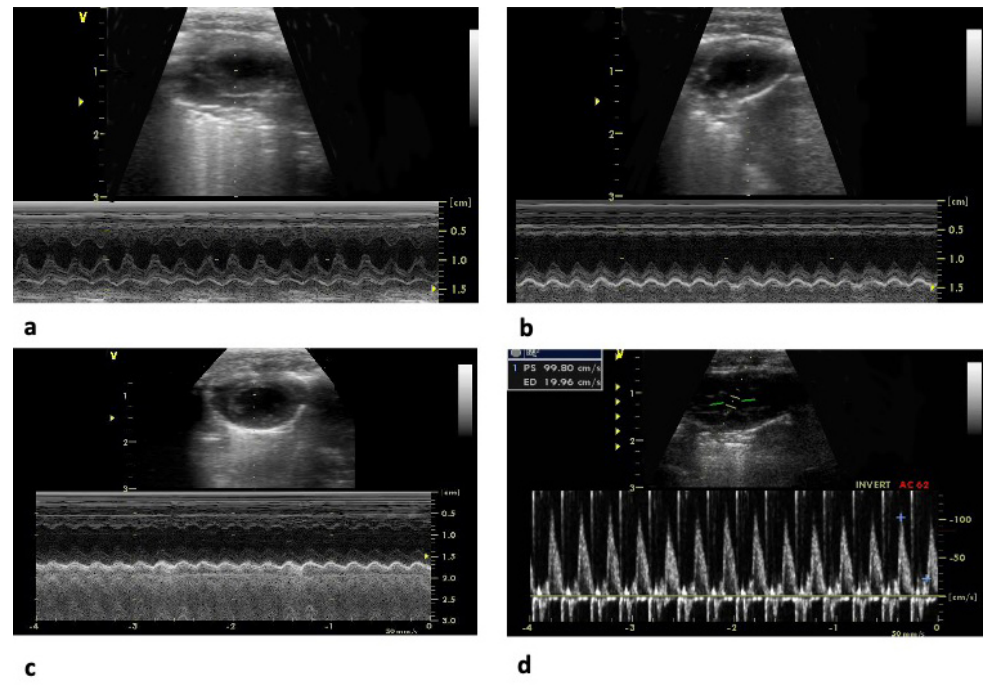
Fig. 2. Representative echocardiograms . (a) Normal anterior and posterior wall motion amplitudes in the SC group; (b) Anterior wall akinesia in the HFC group; (c) Anterior wall dyskinesia in the HFNEB group; (d) Restrictive diastolic dysfunction characterized by increased mitral E wave and decreased mitral E wave flow velocity on pulsed doppler measurement in the HFC group.